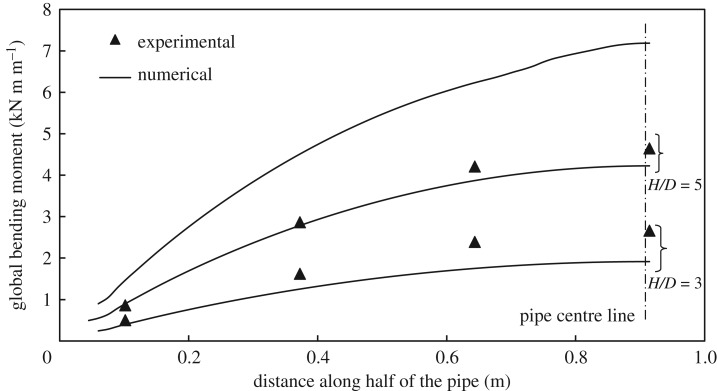
Pipe bending moment distribution at Yu.